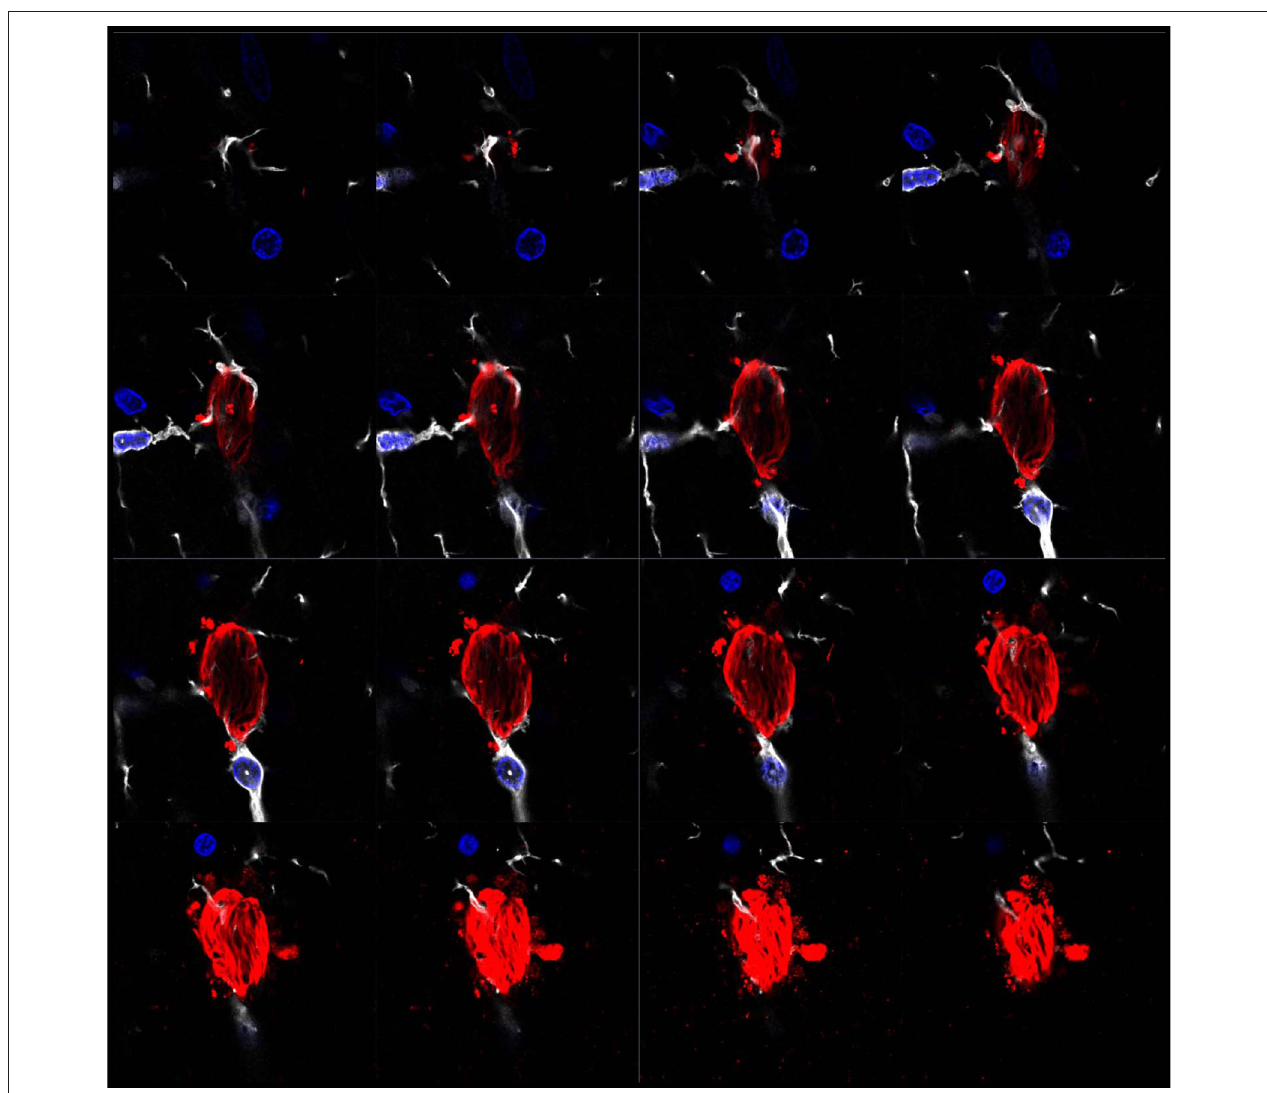
FIGURE 1 | Microglia surrounding phospho-Tau in human brain tissue. Separate z-projection images of a z-stack image showing phospho-Tau surrounded by microglia published by our group previously (Bolós et al., 2015). The authors have the appropriate permissions from the copyright holders. Images show microglia in white (Iba-1), phospho-Tau in red (S396) and nuclei in blue (DAPI).